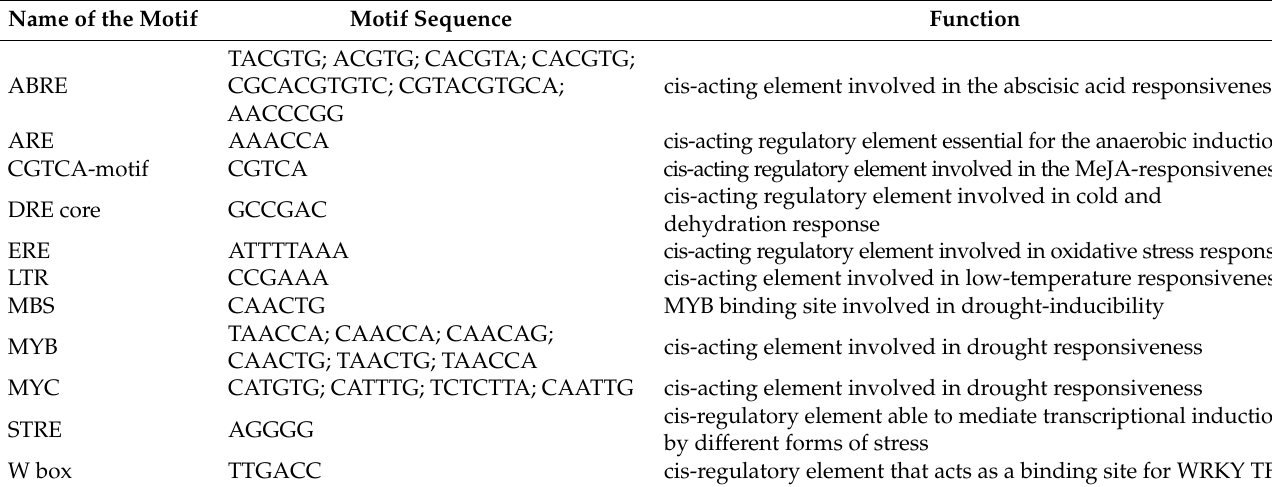
Figure 3. Cis-regulatory elements in the promoter region of AmR2R3 MYB genes. The figure represents the number of each type of stress responsive motifs identified in the promoter sequence of AmR2R3 MYB . Table 3. Cis-regulatory motifs in promoter regions of AmR2R3 MYB